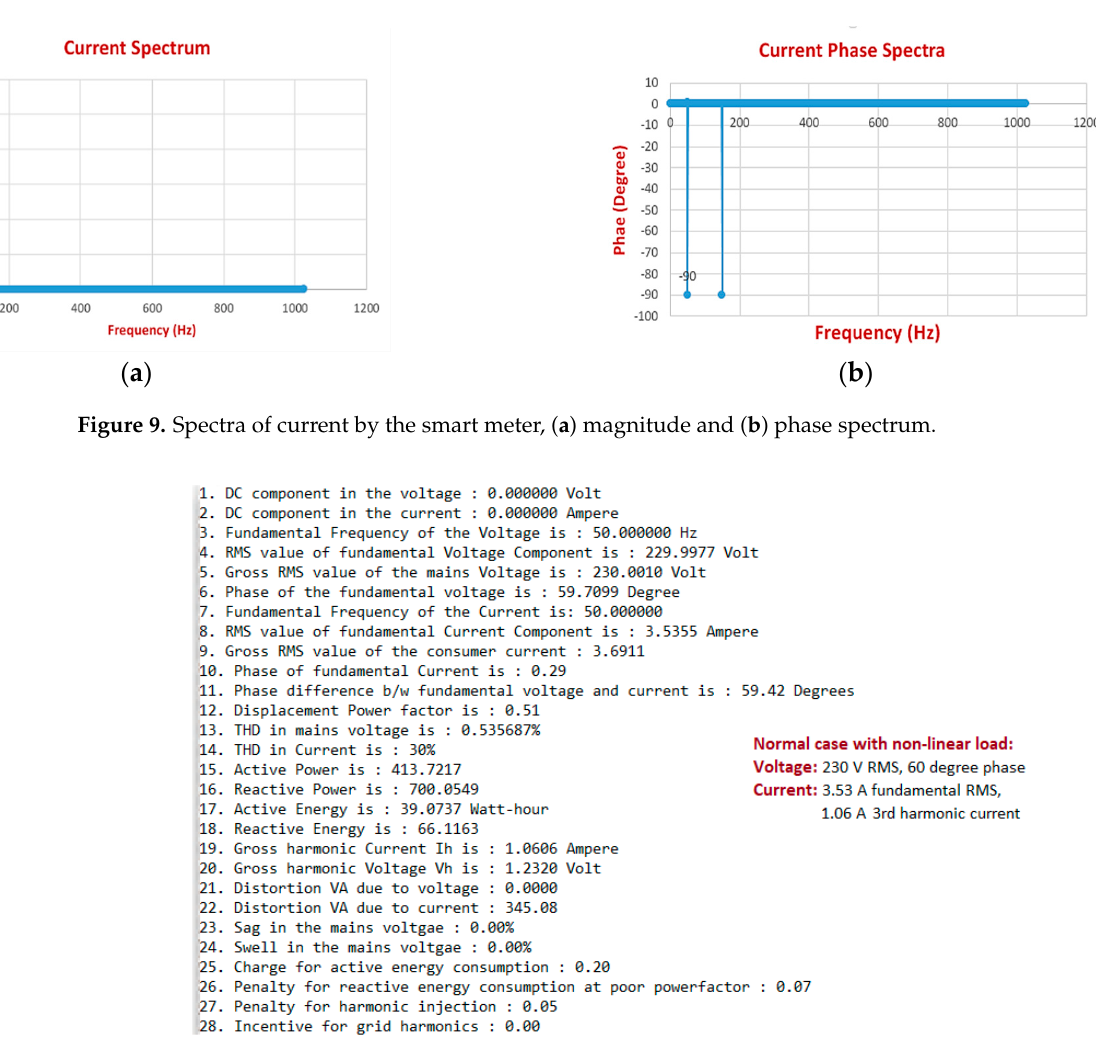
Figure 11. Data communication from the smart meter. 5.2. Hardware Testing Results To verify the efficiency of the hardware setup, the PQ meter is subjected to various operating conditions. A wave shape and phase relationship test and true RMS meas- urement test were carried out, and the results discussed below. 5.2.1. Waveshape and Phase Relationship Test The meter was connected to monitor a 750 W electric iron box load to test the waveshape and the phase relationship. The load was linear and slightly inductive. The code was loaded to the MCU to visualize the voltage and current readings on the serial terminal of a computer, which is shown in Figure 12. It can be noticed from the voltage and current waveforms that the current lagged the voltage and was not contaminated with noise.